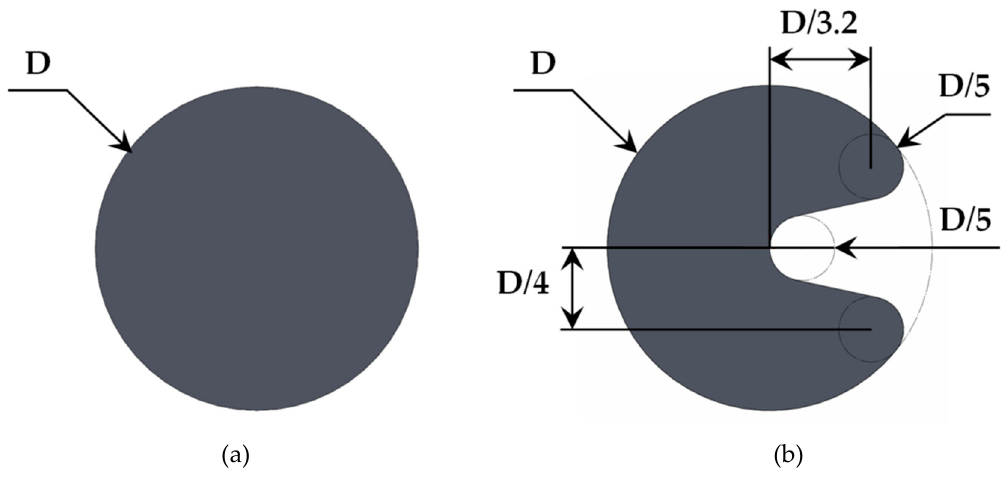
Figure 3. Geometries for the oscillating body. ( a ) Circular cylinder and ( b ) U-shaped geometry.